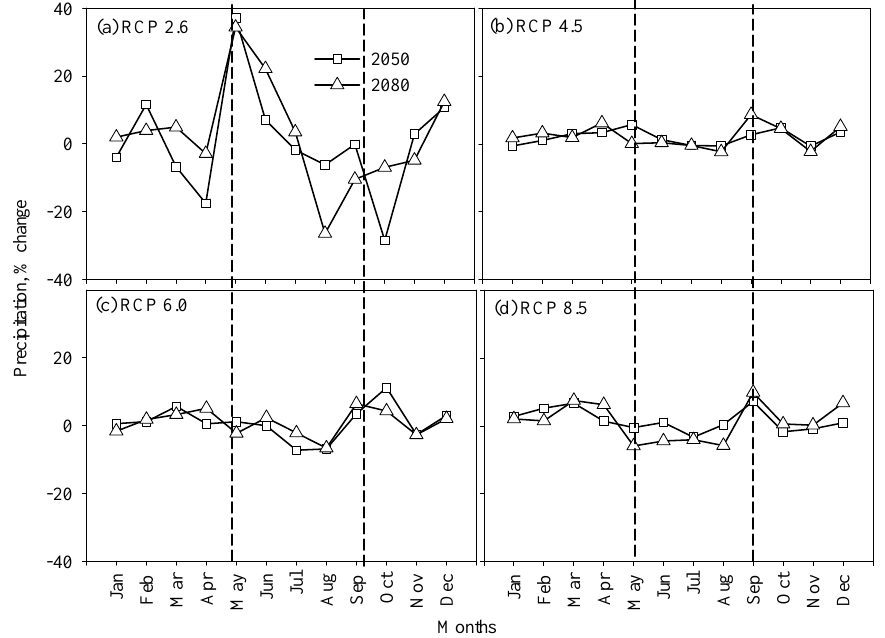
Figure 2. Coupled Model Inter-comparison Project Phase 5 (CMIP5) multi-climate model ensemble projections of rainfall change at Stoneville, MS, for the four emissions scenarios of the Representative Concentration Pathways (RCPs), RCP 2.6 ( a ), 4.5 ( b ), 6.0 ( c ), and 8.5 ( d ), as used in the IPCC Fifth Assessment Report. Dotted lines in the vertical demarcate the normal cotton growth season (May to September).